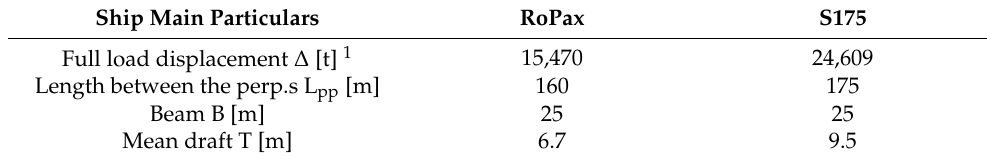
Figure 4. Added Resistance in waves Operator ( ARO ) computed by PDSTRIP for the S175 containership. ( a ) Polar plot of the ARO at the speed of 16.3 knots. Red shading colors for the highest values, yellow shading for intermediate values, light cyan for small values. ( b ) Polar plot of the ARO at the speed of 25 knots. ( c ) Adimensional ARO for the head sea condition, computed by PDSTRIP for several values of the Froude number. Table 1. Main particulars of the ships considered in the examples described in this